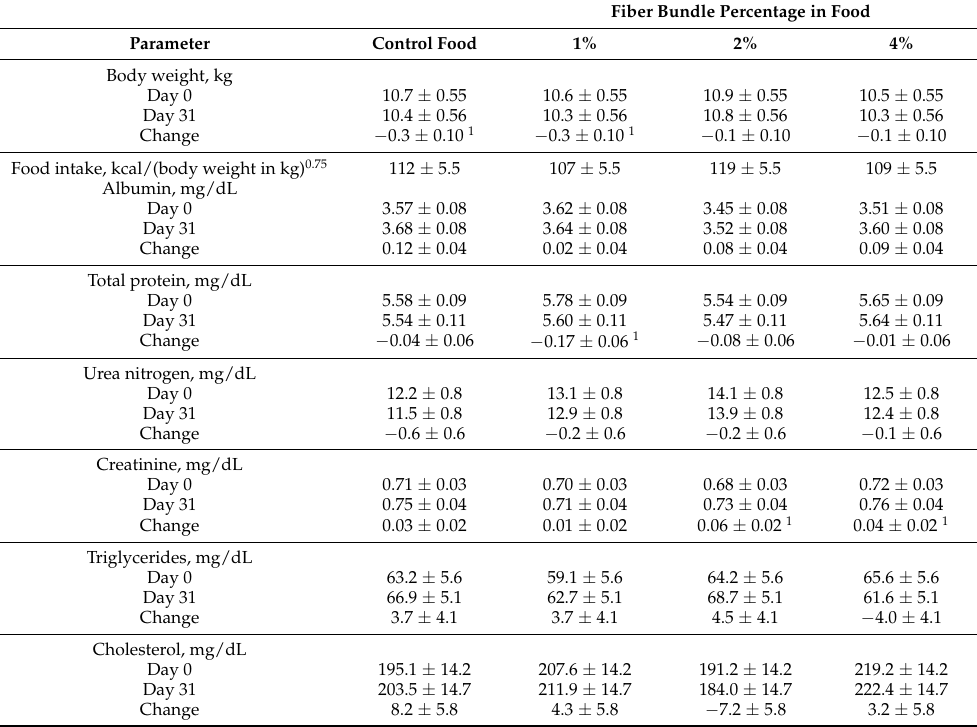
Table 2. Body weight and selected serum biochemistry parameters at baseline, end of study, and change from baseline (Day 0) in dogs that consumed foods containing 0%, 1%, 2%, or 4% of added fiber-bound polyphenol